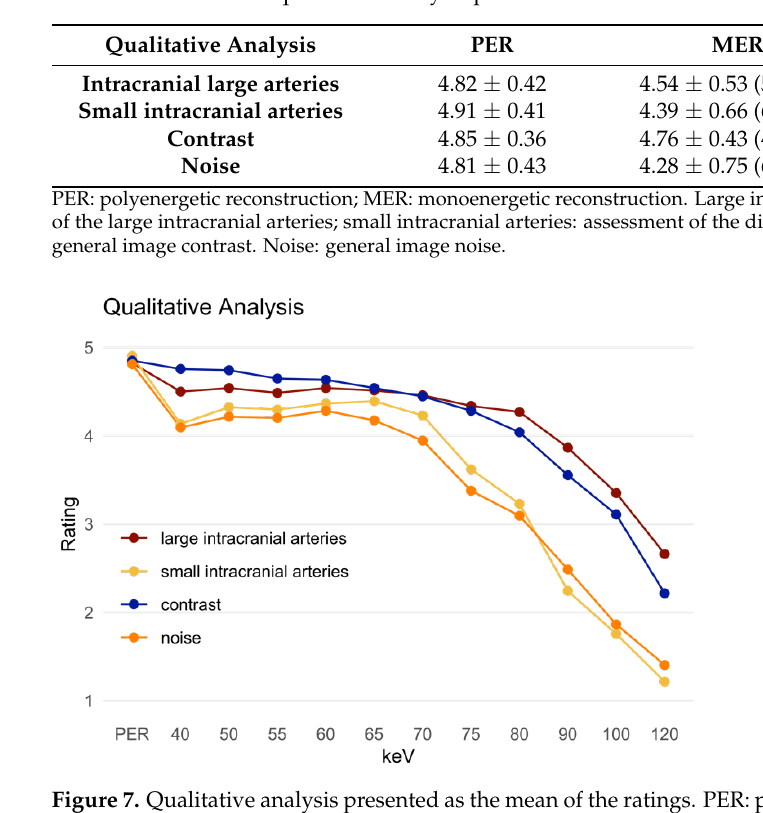
Table 2. Results of the qualitative analysis presented as mean ± standard deviation.